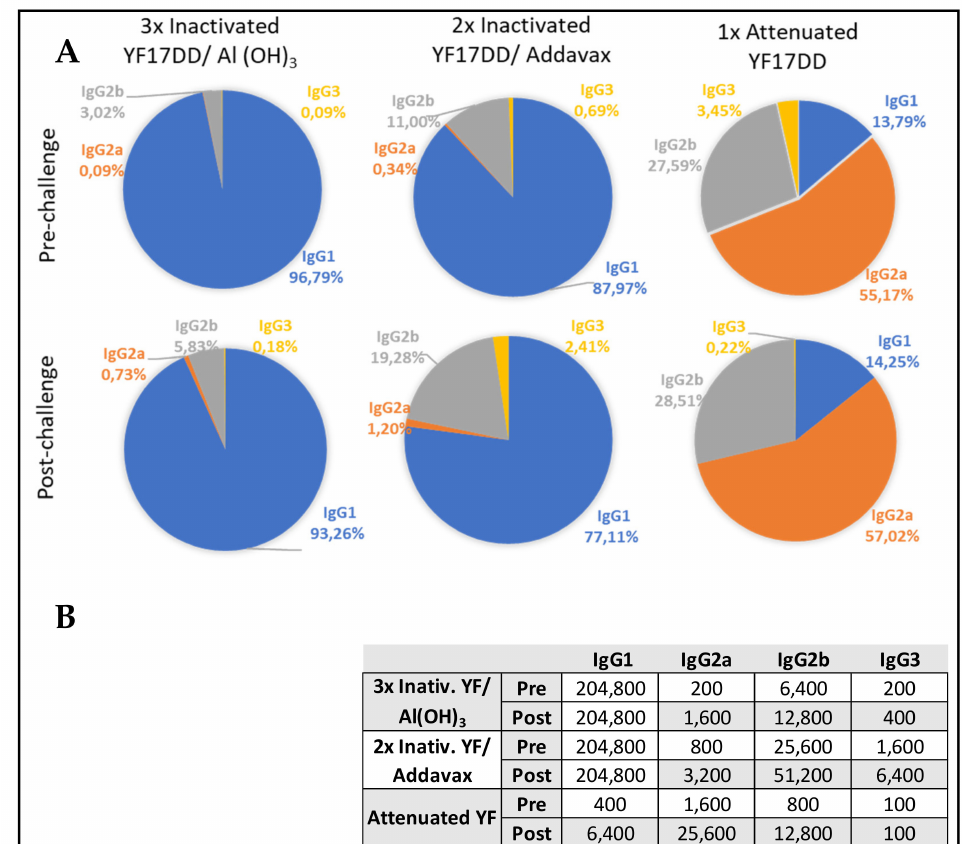
Figure 2. Distribution of IgG subtypes induced by the formulations tested at pre- and post-challenge times. ( A ) Sectoral graphs show the contribution of each IgG subtype to total IgG response induced by each vaccine. ( B ) Quantitative data of IgG subtypes induced by the different formulations.